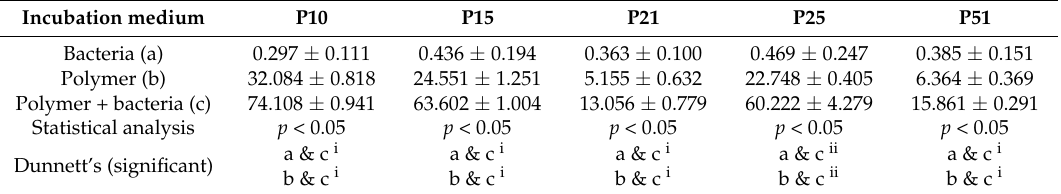
Table 5. Final thiol concentration ( × 10 − 6 M) of different incubation of colon condition, mean ± SD, n =